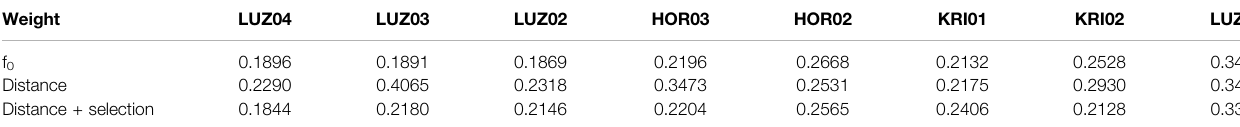
TABLE 1 | RMS between SSR and SSRh calculated using different strategies of weighting intermediate stations. More explanations in the text. Weight